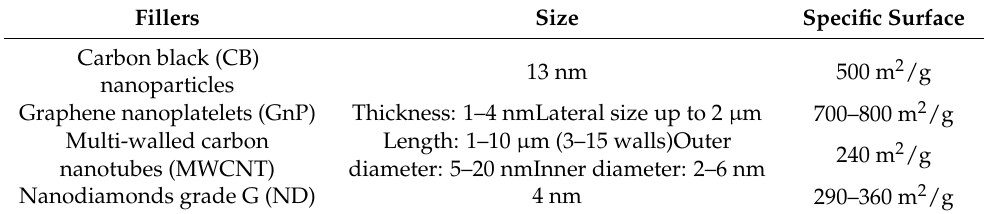
Table 1. The employed carbon allotropes as fillers. Fillers Size Specific Surface Carbon black